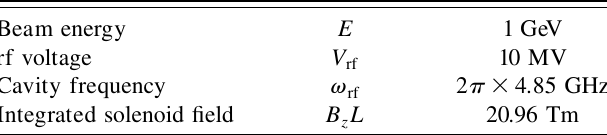
TABLE III. Parameters for estimate of conditioning provided by a solenoid conditioner. Beam